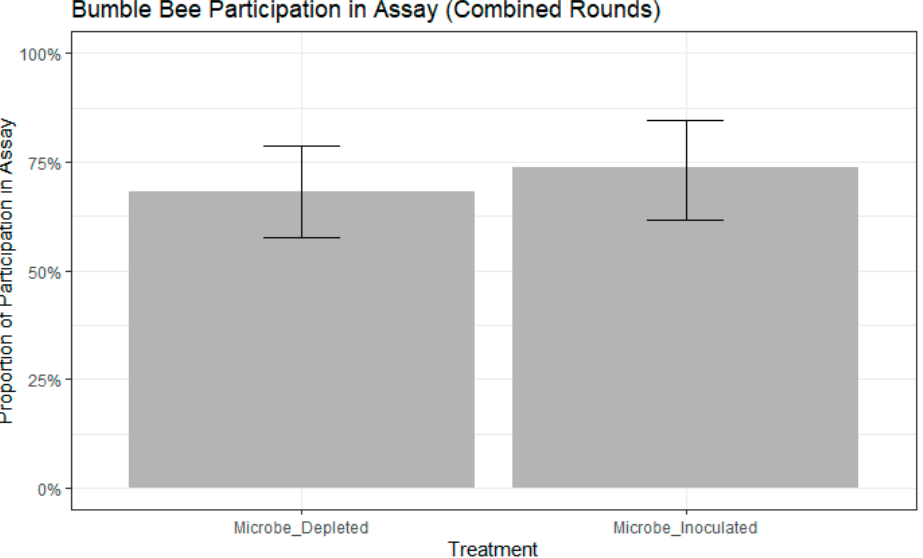
Figure 2. Bumble bee participation in free-moving proboscis extension response (FMPER) assay. No significance between treatments as determined by binomial generalize linear mixed model (GLMM) with maximum likelihood: std. error = 0.4111, z = 0.911, p = 0.362. Error bars indicate 95% confidence intervals.